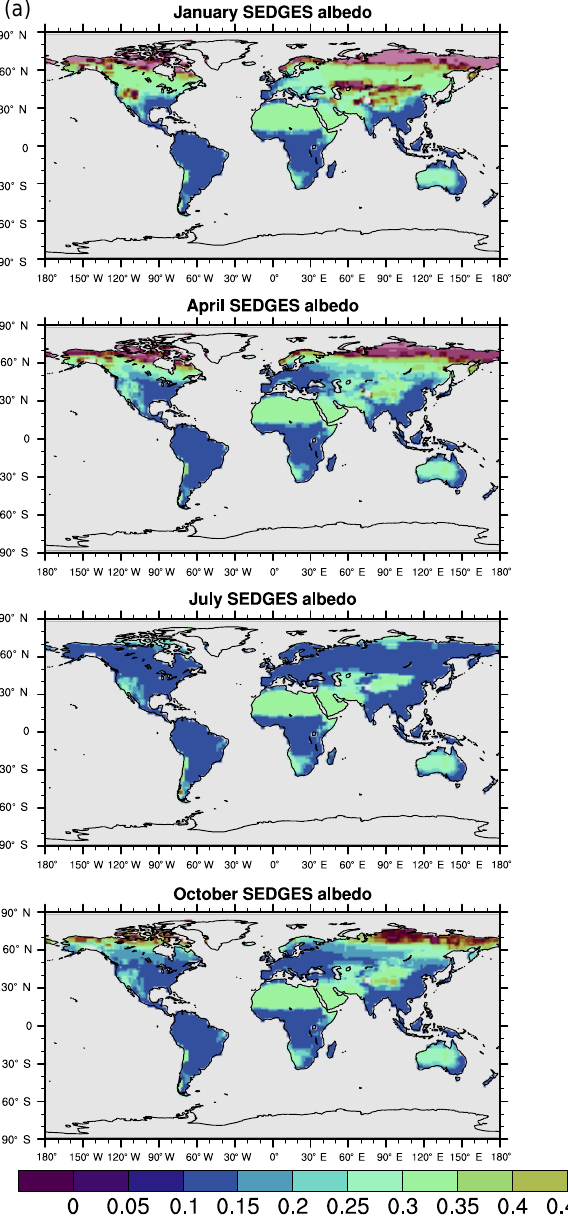
Figure 4. (a) SEDGES monthly mean climatologies of surface albedo for 2001–2010. (b) MODIS monthly mean climatologies of white-sky albedo for 2001–2010 (NASA LP DAAC,